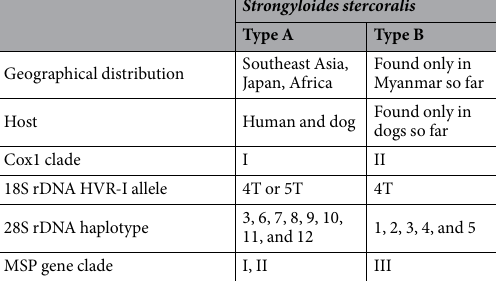
(Ia–e) may indicate that the Cox1 diversity currently observed in clade I already existed before the divergence into human- and dog-adapted strains of S . stercoralis Type A. HVR-I genotypes differ according to host species, suggesting that the divergence of dog and human strains might predate the dispersal of S . stercoralis to different geographical locations in Asia. On the other hand, the typ- ing data for the 18S rDNA 458 T/A polymorphism show that they are different according to geographical location rather than to the host species. It might be possible that the nucleotide substitution at position 458 might have occurred independently in both dog- and human-infecting strains in Japan, without a true phylogenetic rela- tionship. An alternative and more complex scenario is the double occurrence of divergence into dog and human strains, one in genotype T/T worms of the 458 T/A polymorphism and the other in genotype A/A worms. More typing data using samples from more diverse geographical locations with more genetic markers are required to draw any conclusions. Eight human samples contained worms with at least one 4T allele (genotypes 4T/4T or 4T/5T). There was no case in which only the 4T/4T genotype was found in human samples (Table 3). These 4T/4T worms were always found together with 4T/5T or 5T/5T worms isolated from the same agar plate, indicating that a heterozygous par- asitic female might have been the source of these worms. After sexual reproduction occurred on the agar-plate, these mixed-genotype progeny, including 4T/4T individuals, might have been produced. Regarding the means of reproduction of the free-living adults of Strongyloides , earlier cytological studies (Hammond and Robinson 16 for S . stercoralis 16 , Nigon and Roman 17 ; Bolla and Robers 18 for S . ratti 17, 18 ; Zaffagnini 19 ; Triantaphyllou and Moncol 20 for S . papillosus 19, 20 , and Triantaphyllou and Moncol 20 for S . suis ) 20 proposed sperm-dependent parthenogen- esis (pseudogamy). This proposal was disproved later for S . ratti 21 and S . pappilosus 22 using molecular genetics approaches. In case of S . stercoralis , a recent report suggests that the sexual reproduction of free-living adults